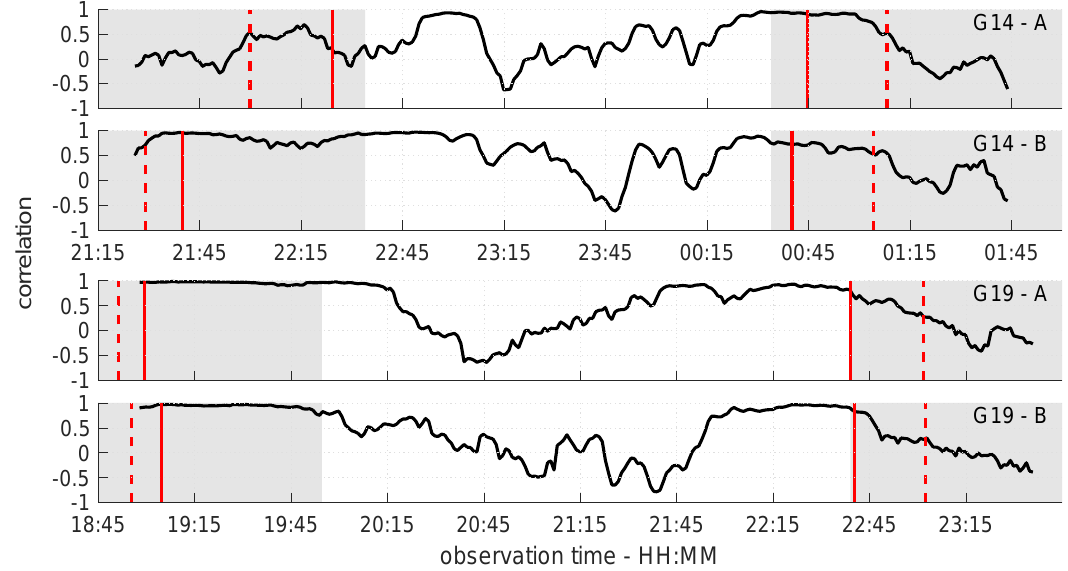
Figure 22. Correlation of simulated and observed δ -SNR time series for satellites G14 ( top two panels) and G19 ( bottom two panels). The grey shaded region represents the part of the observation duration where the Rayleigh criterion is